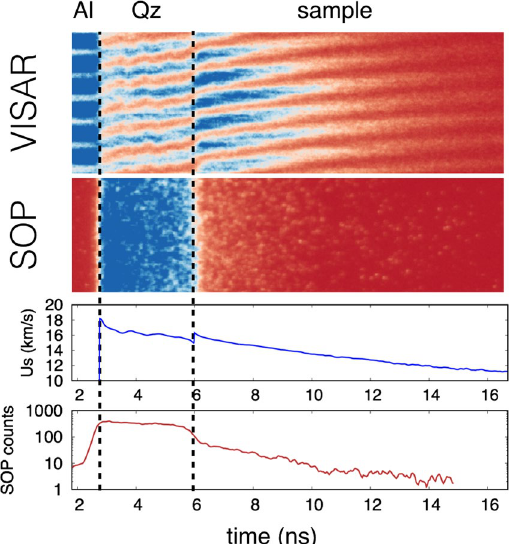
Figure 1. Diagnostics output of a typical shot on the SPM at the GEKKO facility. From top to bottom: VISAR image; SOP image; time-resolved shock velocity; time-resolved SOP counts. The three time intervals indicate when the probe laser is reflected by aluminium (Al), when a reflecting shock front is propagating through the quartz layer (Qz), and when the shock front is propagating through the mixture sample. The transverse target dimension is ~180 μ